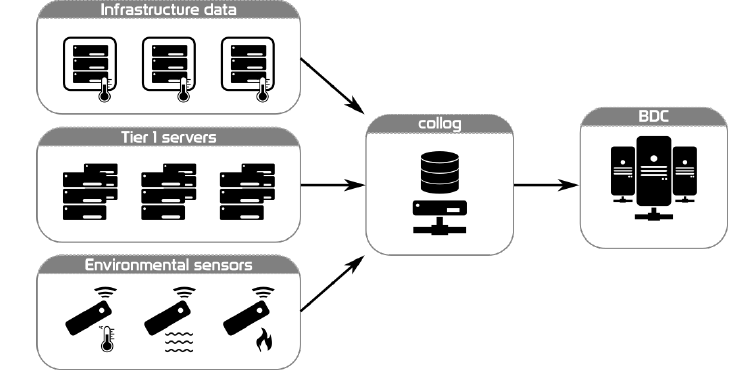
Figure 1. High-level view of INFN’s Tier-1 big data infrastrucure for log